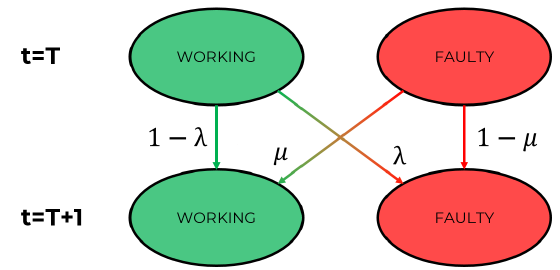
Figure 3. Transition between working and faulty operation of the component i from time T to time T + 1.